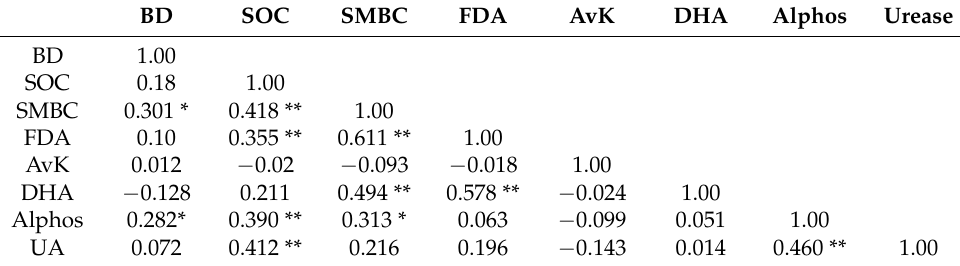
Table 6. Correlation matrix of higher weighted factor loading under different PC.